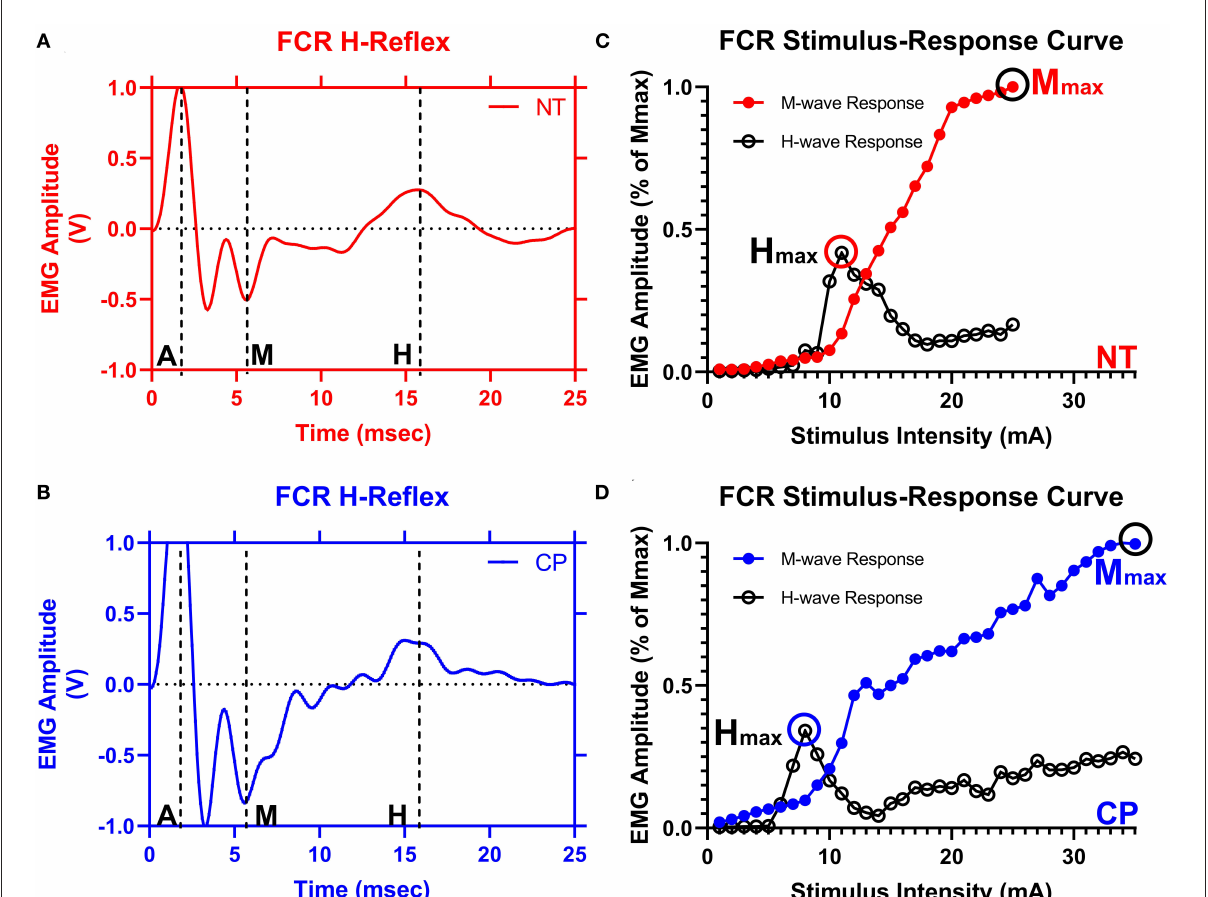
FIGURE2 The flexor carpi radialis H-reflex is reduced in adults with cerebral palsy. Averaged H-waves and M-waves across stimulus intensities from an exemplary neurotypical (NT) adult (A) and an adult with cerebral palsy (CP) (B) are shown. The exemplary subjects were chosen based on their similarity to the means of the respective groups. EMG amplitude from the flexor carpi radialis (FCR) muscle is shown on the y-axis and time (ms) is denoted on the x-axis, with 0ms defined as the onset of the stimulus artifact. As can be discerned in (A,B) , there is an M-wave response around 4 to 5ms after the stimulus artifact and an H-wave response around 14 to 16ms after the stimulus. M, M-wave; H, H-wave; A, stimulus artifact. (C,D) show M-wave (closed circle) and H-reflex (open circle) recruitment curves obtained with median nerve stimulation from the same exemplary NT control and adult with CP. Response peak-to-peak amplitudes were normalized to the maximal M-wave response (Mmax) and shown on the y-axis and stimulus intensity (in mA of current) is denoted on the x-axis. As depicted, the H-max was lower for the adult with CP when compared with the NT